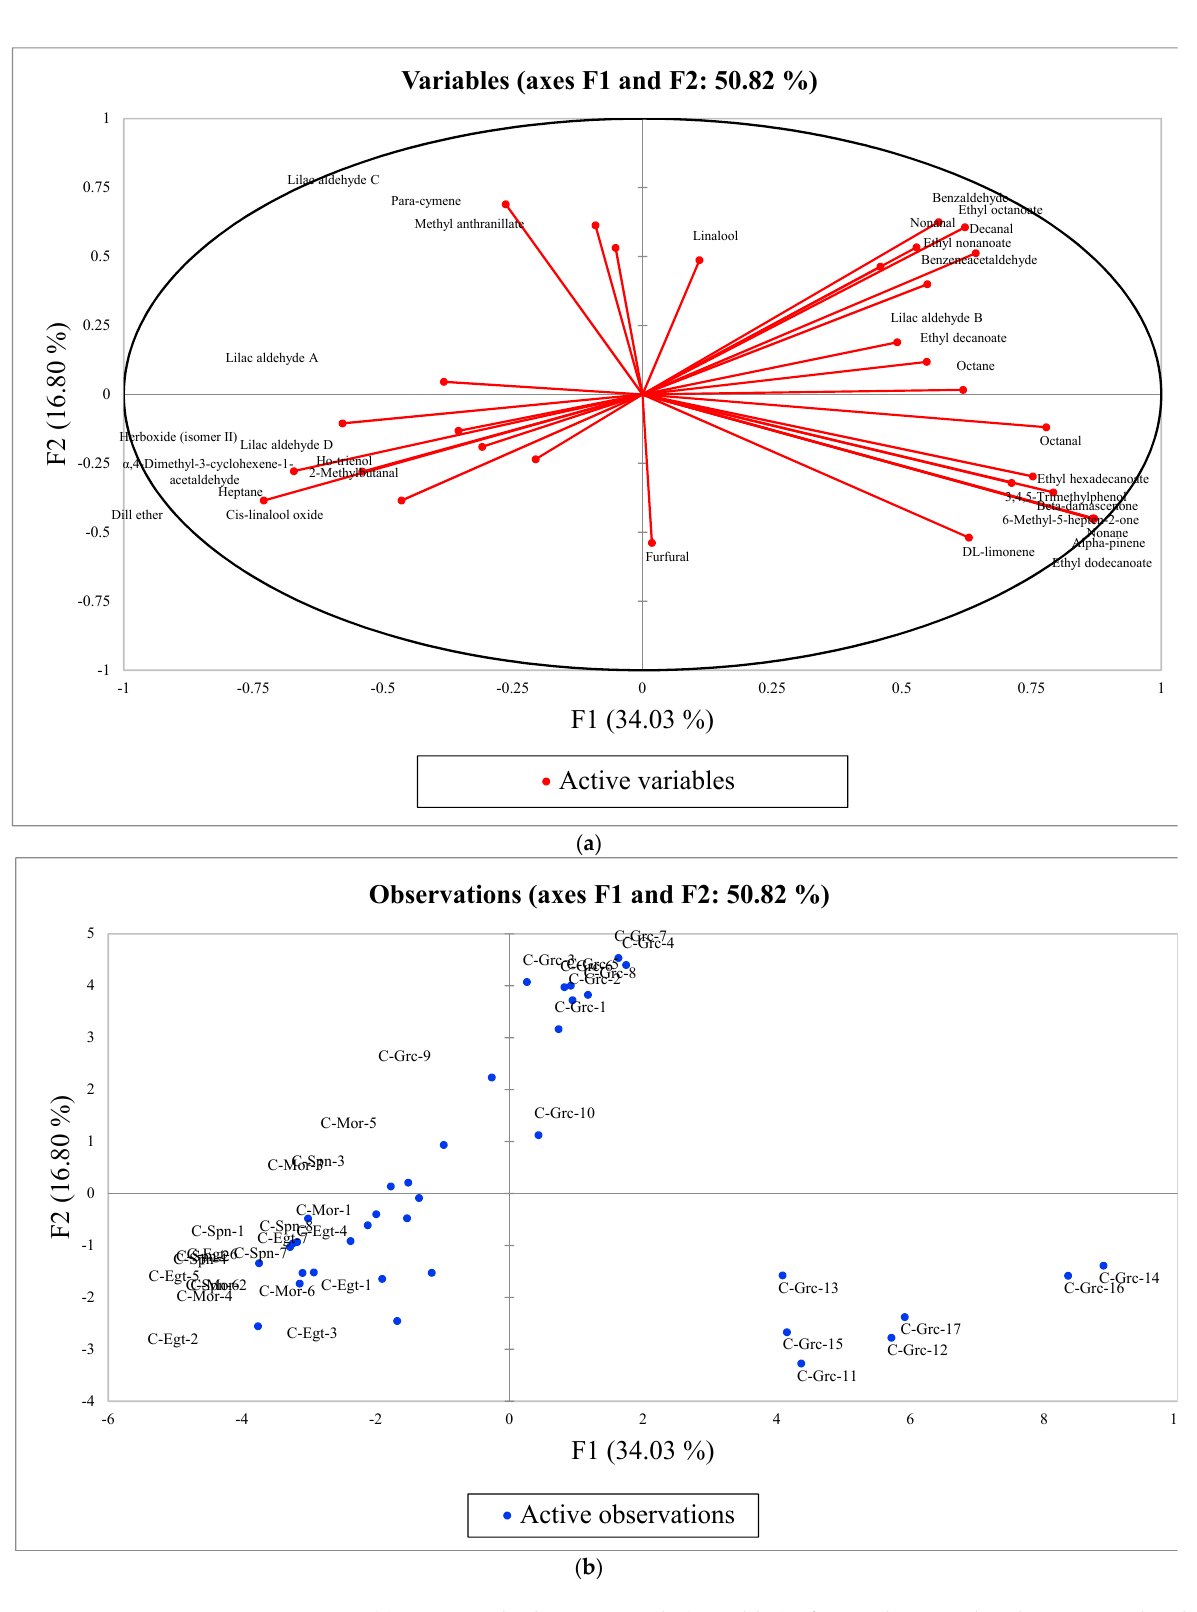
Figure 2. ( a ) Active volatile compounds (variables) of citrus honey related to geographical origin based on PCA. α : alpha; β : beta. ( b ) Score plot (distribution of citrus honey samples) in the multi- dimensional space of PCA with respect to geographical